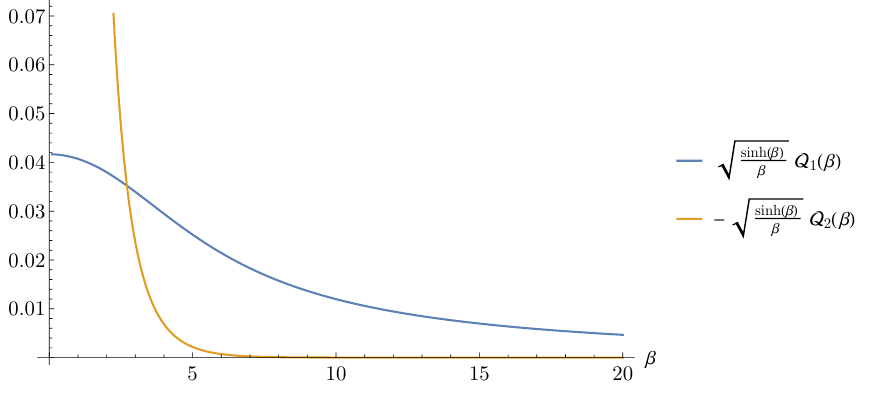
Figure 18. The functions Q 1 ( β ) and −Q 2 ( β ) , multiplied by a standard factor (sinh β/β ) 1 / 2 . Both are everywhere positive. −Q dominates (5.63) in the flat space regime β (cid:28) 1 but Q 2 at large β